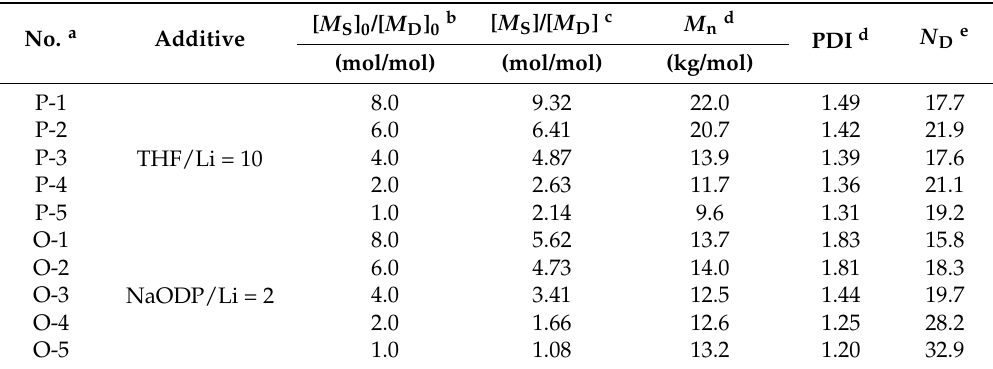
Table 2. Composition and structure results for the copolymerization of styrene and DPE-SiOEt in the presence of the